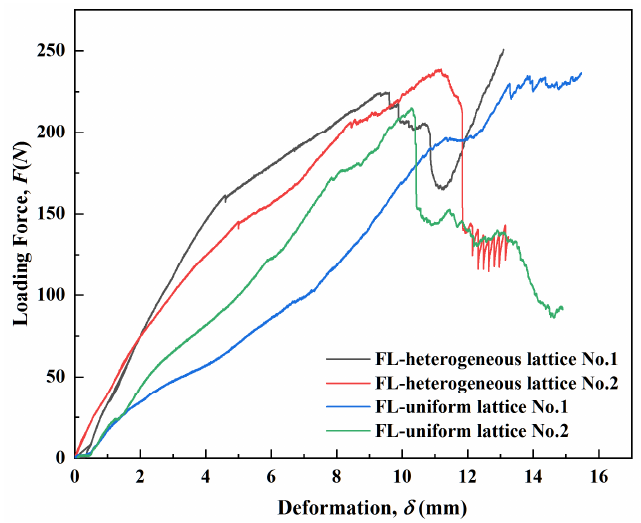
Figure 10. The bending load–displacement curves of the four lattice hybrid structures. Table 2. Mechanical properties of the designed structures.